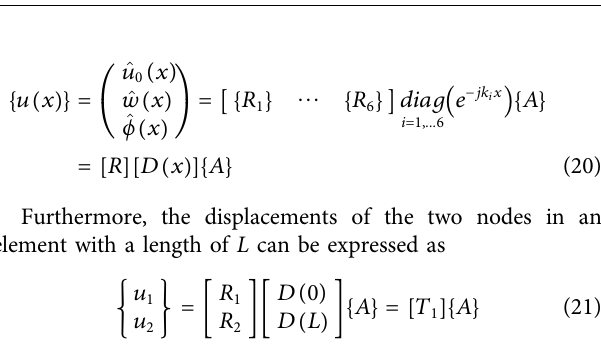
FIGURE 4 | Load-de fl ection comparison at the midspan. FIGURE 5 | Load-strain relationship of the FRP bar at the